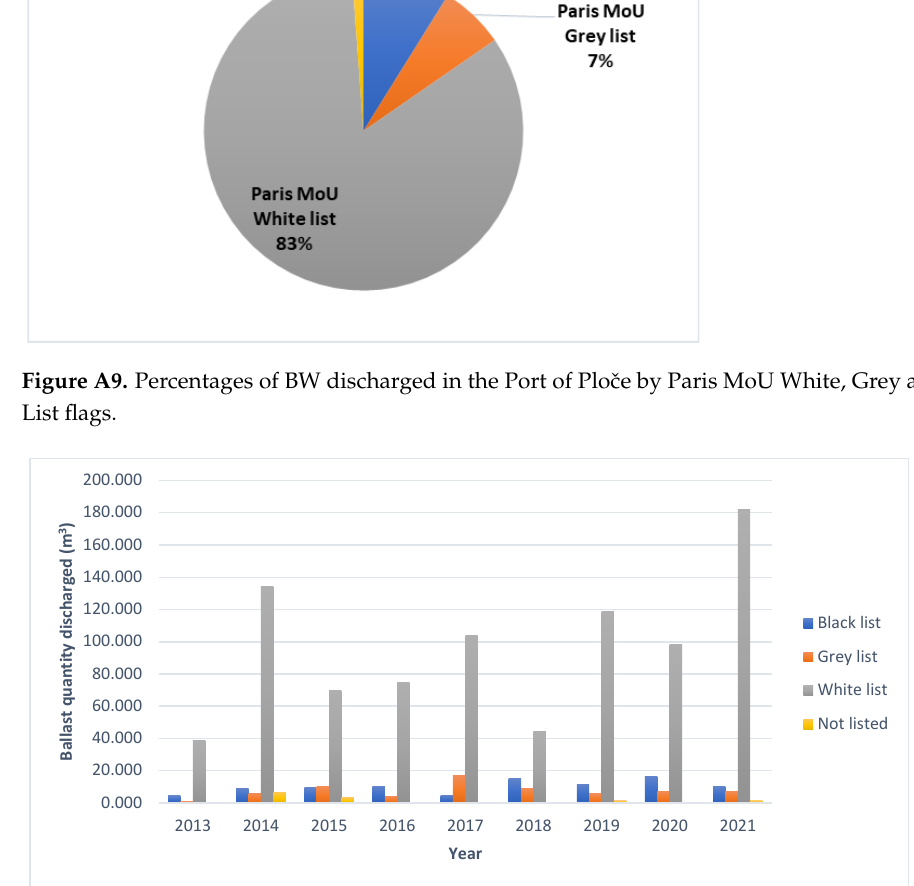
Figure A10. Annual BW quantities discharged in the Port of Ploče by Paris MoU White, Grey and Black List flags.